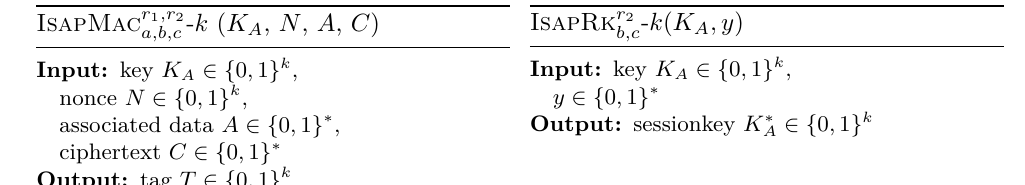
Algorithm 3: Suffix MAC IsapMac and re-keying function IsapRk